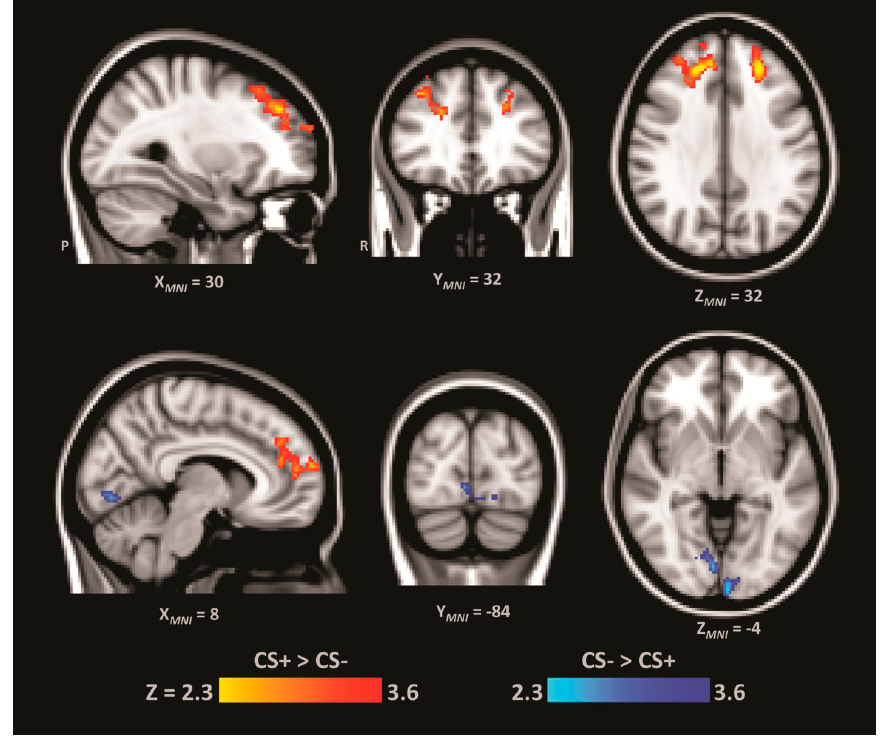
Figure 4. Brain regions showing both greater connectivity with S1 during CS+ than CS − (RED–YELLOW) and less connectivity with S1 during CS+ than CS − (BLUE–LIGHT BLUE). This reveals increased connectivity during CS+ trials between right S1 and bilateral dlPFC and dmPFC. It also reveals decreased connectivity during CS+ trials between right S1 and parts of lingual gyrus.